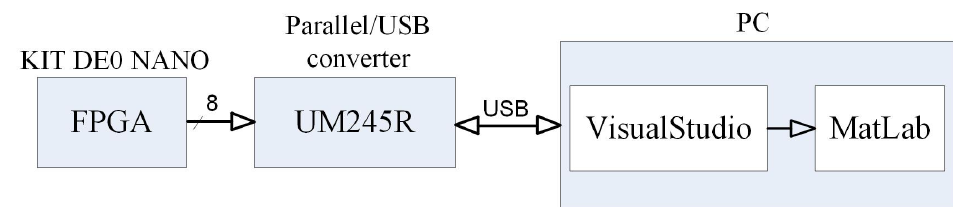
Figure 27. Blocks outline for evaluating the SPSS signal waveform.